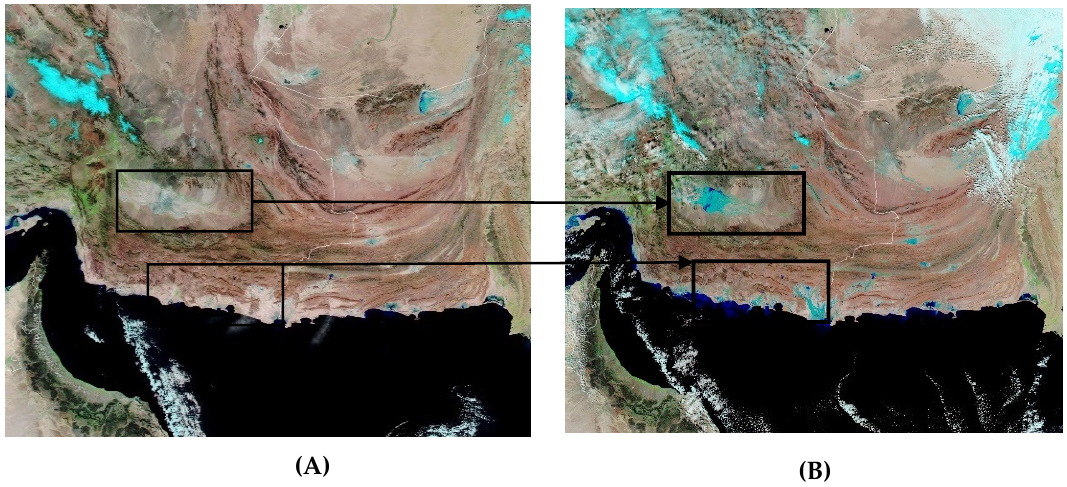
Figure 4. Moderate-Resolution Imaging Spectroradiometer (MODIS) images of the study area ( A ) before the flooding on 8 January 2020, and ( B ) during the flood on 13 January 2020. The dark blue regions are the inundated areas. The clouds in the image are shown with light blue which can be distinguished from the inundated areas [39].